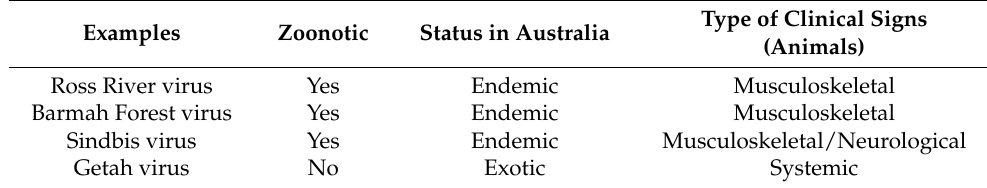
Table 1. Alphaviruses of concerns in Australia included in this